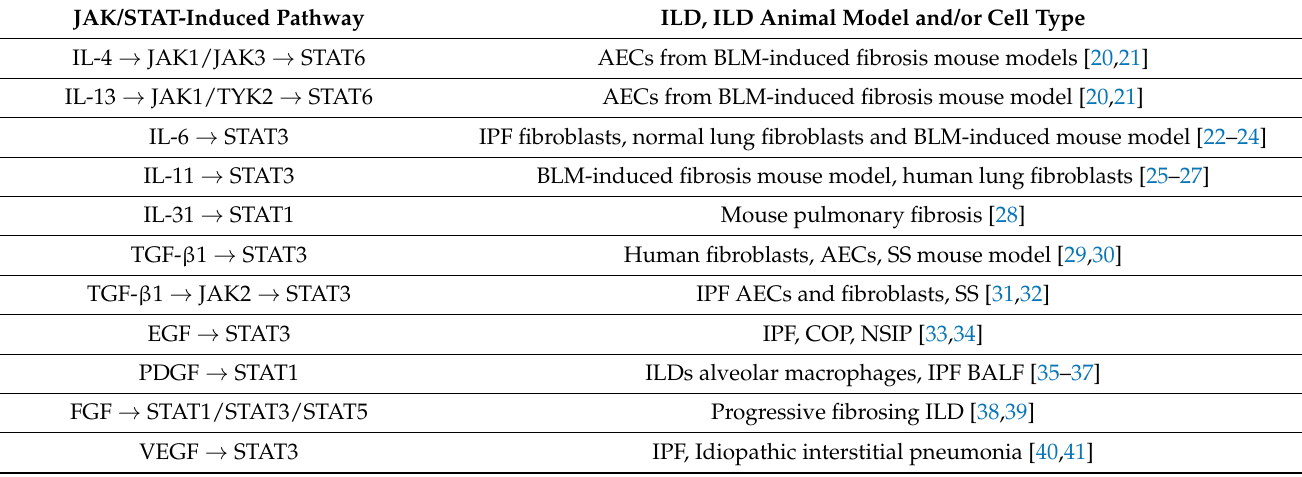
Table 2. Summary of the different JAK/STAT signaling pathways and its activators in ILDs. The left column shows the JAK/STAT induced pathway for each activator. The right column shows the specific human ILD, ILD animal model, or cells in which the mentioned pathway was